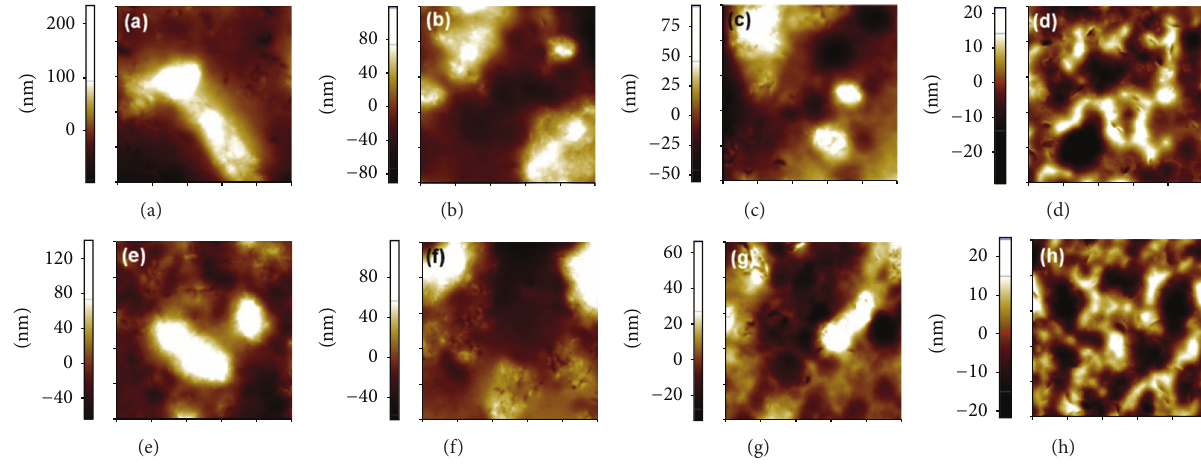
Figure 8: AFM images of the blended films under various ratios (a) DSi-6T :PCBM 1:4w/w nonannealed (e) annealed and (b) DSi- 6T :PCBM 1:5w/w non-annealed (f) annealed and (c) DSi-6T : PCBM 1:6 w/w non-annealed (g) annealed and (d) DH-6T :PCBM 1:6w/w non-annealed (h) annealed. The image scan sizes is 5 𝜇 m × 5 𝜇